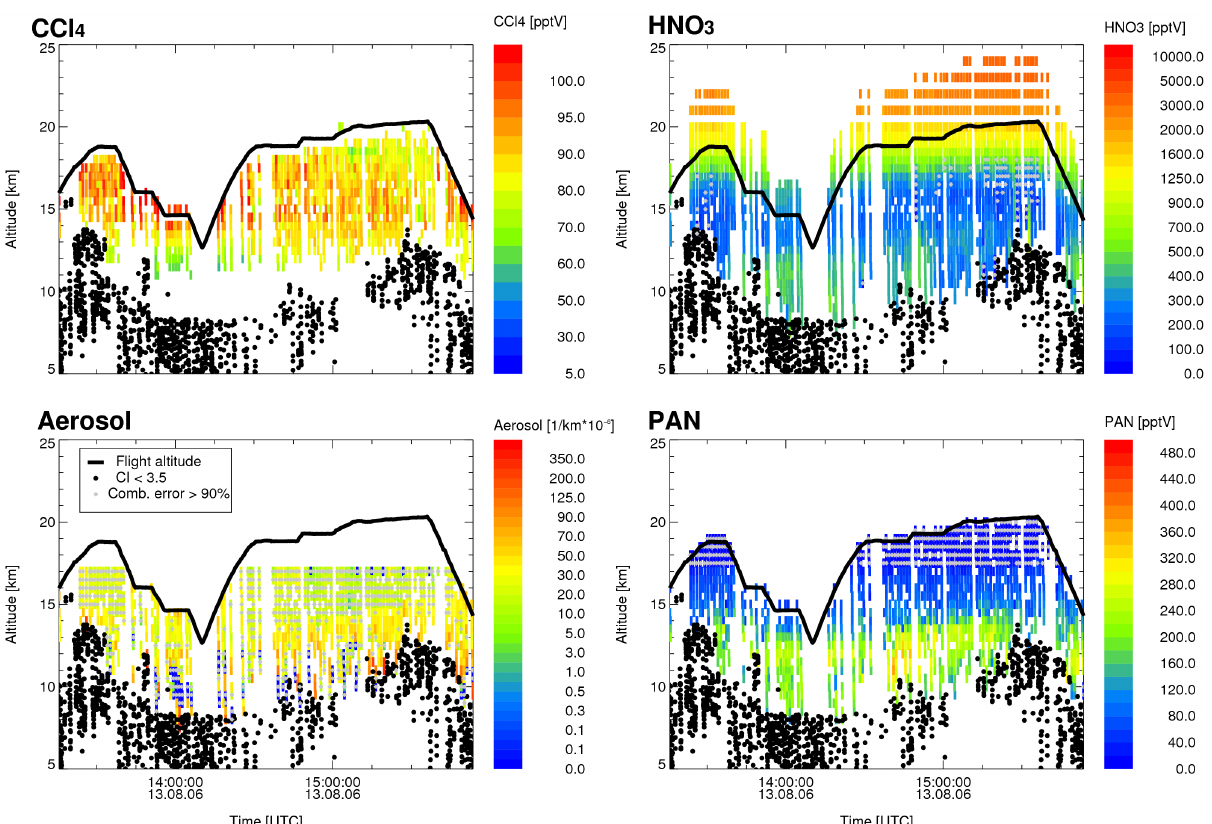
Fig. 14. CRISTA-NF results for CCL 4 , HNO 3 , aerosol extinction and PAN. Black dots mark spectra with a CI lower than 3.5. Note nonlinear color